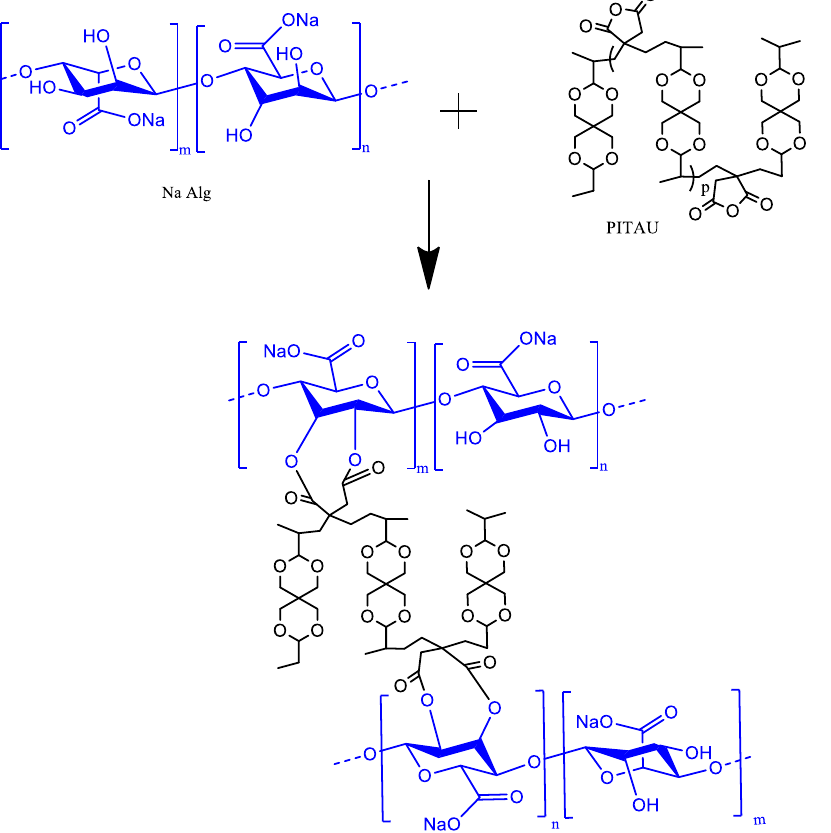
Figure 1. Schematized PITAU–alginate network.